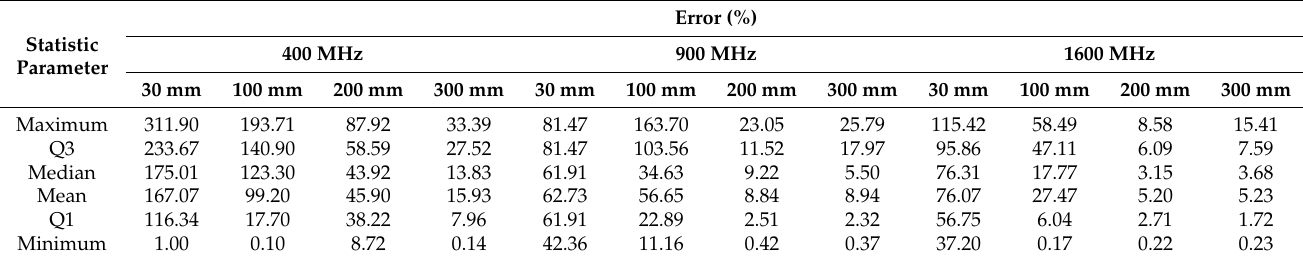
Table 6. Summary of statistical parameters for distribution of errors in predicted thicknesses of air-cavities shown in Figure